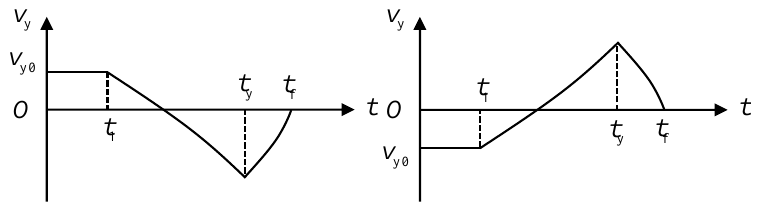
Figure 2. Two motion modes in the Y direction.